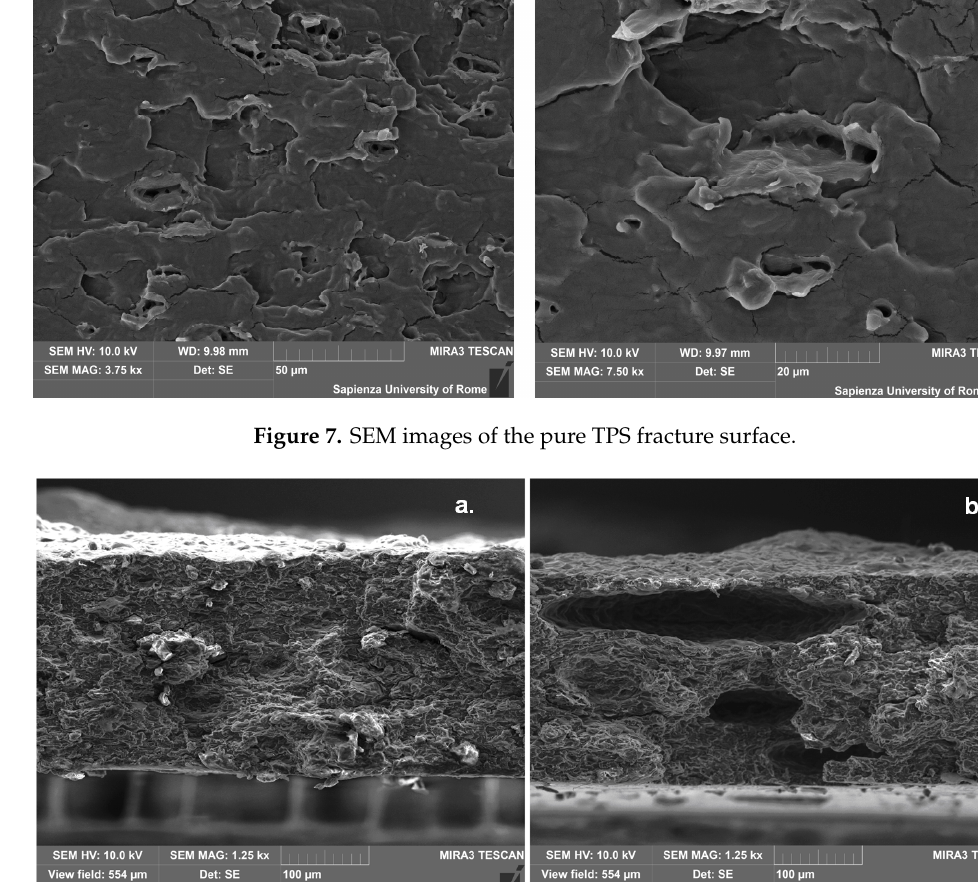
Figure 9. Leather particles embedded in the TPS matrix, 1/2( a ), 1( b ) 3/2( c ).